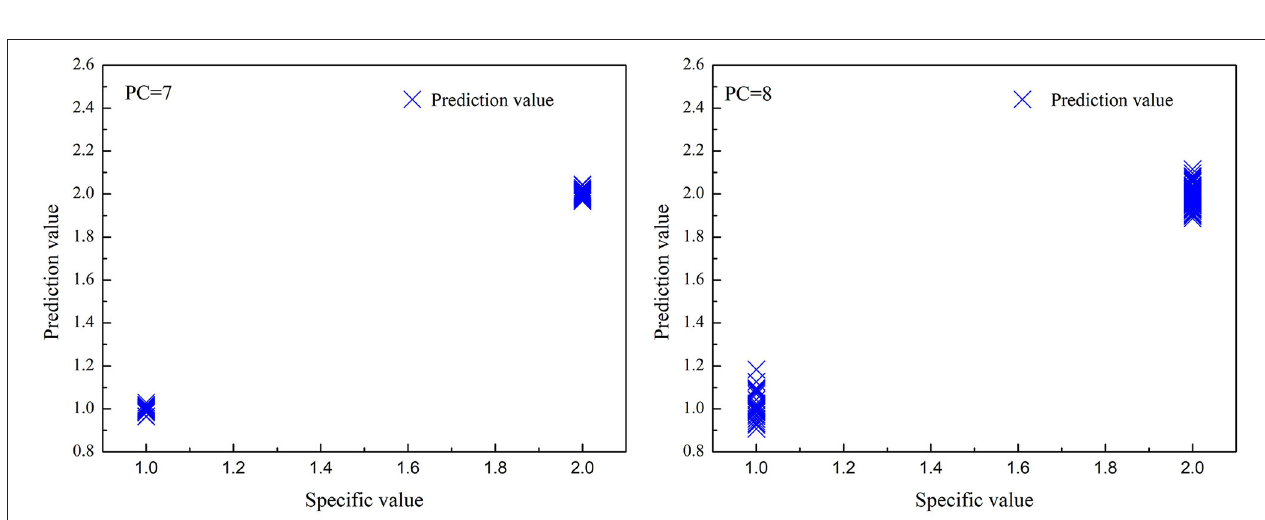
FIGURE 5 | The correlations between predicted value and specified value for partial least squares regression (PLS) models in the prediction set. (left): high deuteration rate (20–60%) fibers and protonic fibers; (right): high and low deuteration rate (1–60%) fibers and protonic